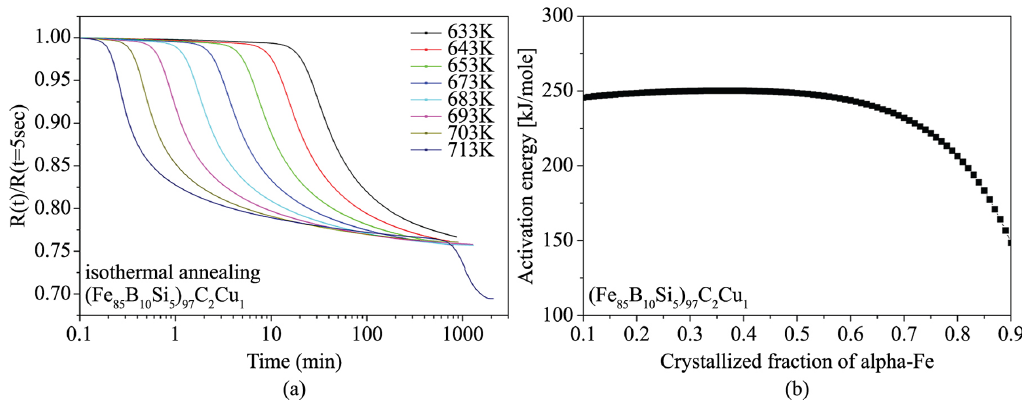
Figure 8. (a) Evolution of relative electrical resistivity for the Fe-B-Si-C-Cu system during isothermal annealing at marked temperatures. (b) Dependence of activation energy of crystallization of bcc-Fe during the first stage of transformation.